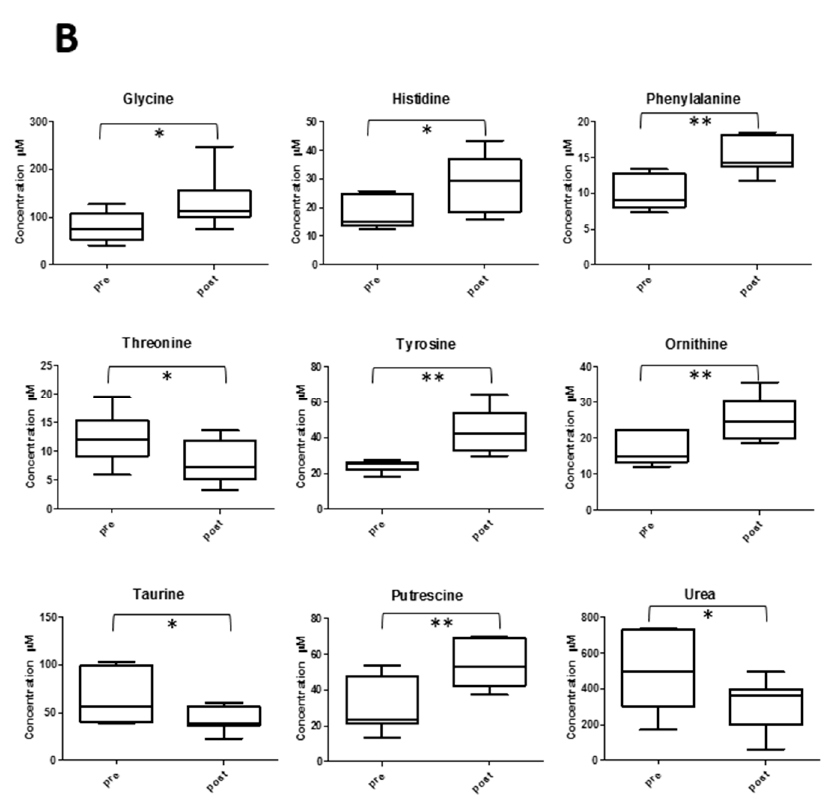
Figure 8. Concentration changes between pre- ( left ) and post- samples ( right ) in amino acids and related metabolites in saliva using TPWS ( A ) or TOMC ( B ) data normalization. In A metabolite concentrations are expressed as µ M / mg of total proteins, in B as µ M / total metabolic output. The boxes denote interquartile range, lines denotes median, whiskers denotes 5th and 95th percentile. * p < 0.05; ** p < 0.01.